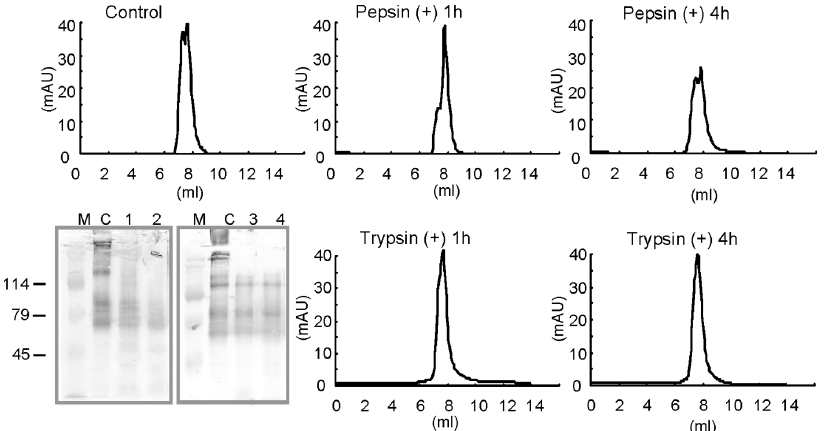
Figure 2. Tolerance of SRf1 against gastric protease digestion. SRf1 was digested in the presence of pepsin (1 mg/mL) at pH 2 or in the presence of trypsin (0.4 mg/mL) and chymotrypsin (1.7 mg/mL) at pH 7.4. After 1 or 4 h digestion, the reaction mixture was applied to a Superose 6 gel filtration column, and peak areas were compared to those of the control. Panel B: 1D-western blot analysis of digested SRf1s detected using sera from dogs infected 5 times. Lanes: M, molecular marker; C, controls (no proteases); 1 and 2, pepsin digestion for 1 and 4 h, respectively; 3 and 4, tryptic digestion for 1 and 4 h, respectively.